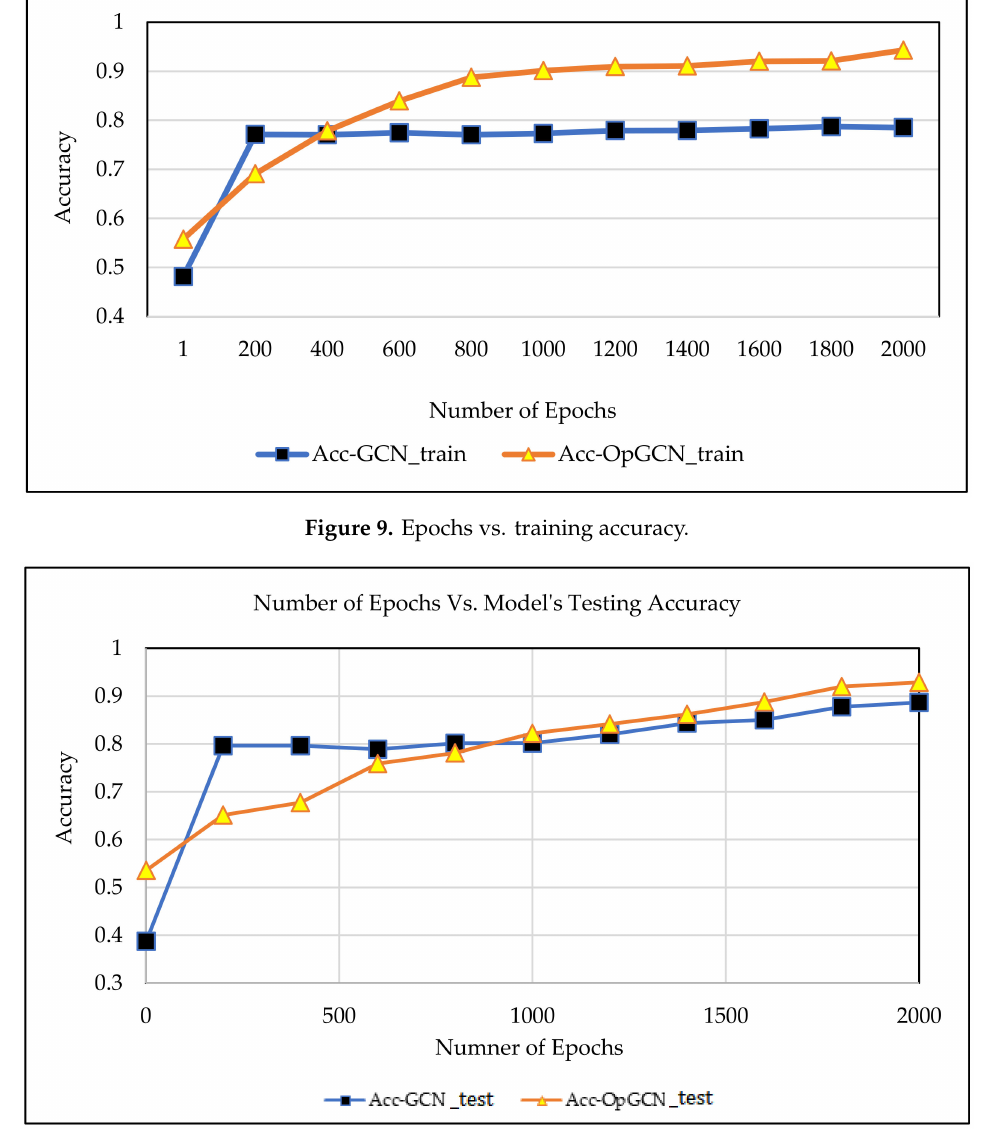
Figure 10. Epochs vs. testing